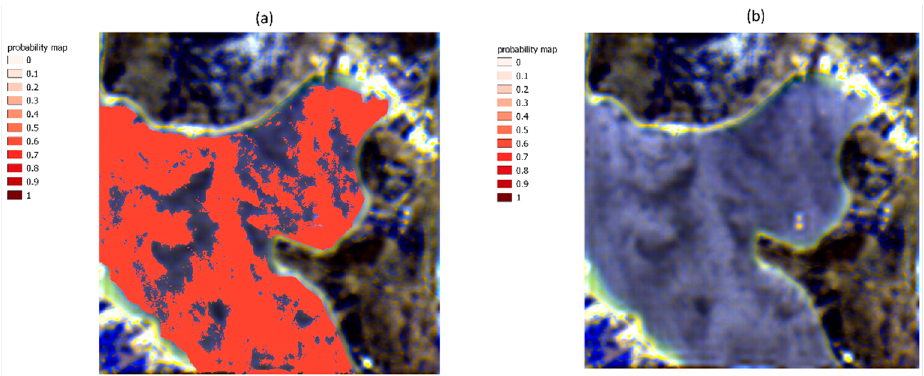
Figure 10. Results of the application of the supervised and unsupervised ML algorithms trained during the configuration phase and applied on the PRISMA image collected on 29 June 2021 over the Geras Gulf. ( a ) The probability map ranges between 0 and 1. ( b ) The probability mask with only values greater than 0.80: no significant results were obtained with this test.